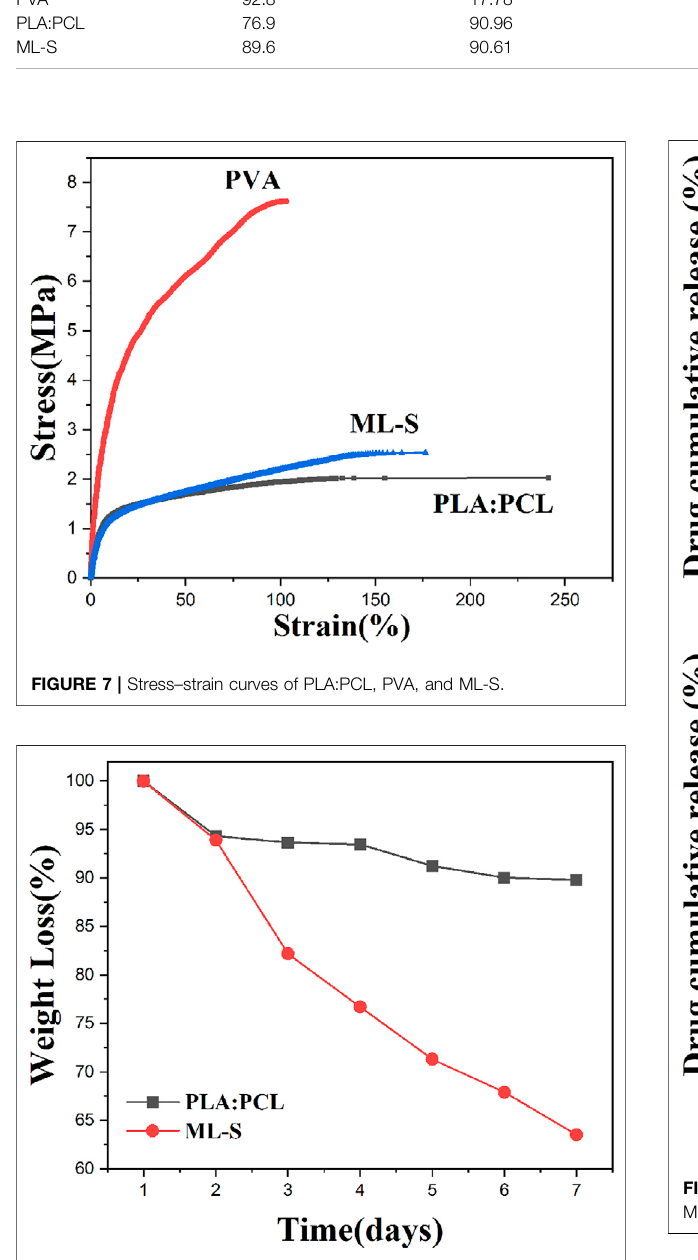
FIGURE 8 | Biodegradation study of PLA:PCL and ML-S.